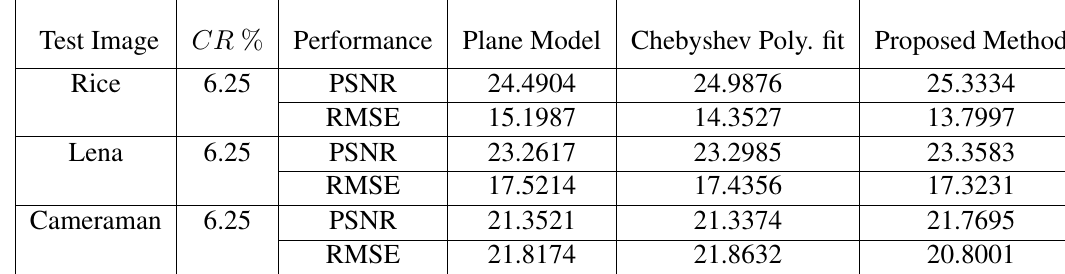
Table 5: Performance comparison with Polynomial fitting model and Chebyshev polynomial surface fit model in the case of 4 × 4